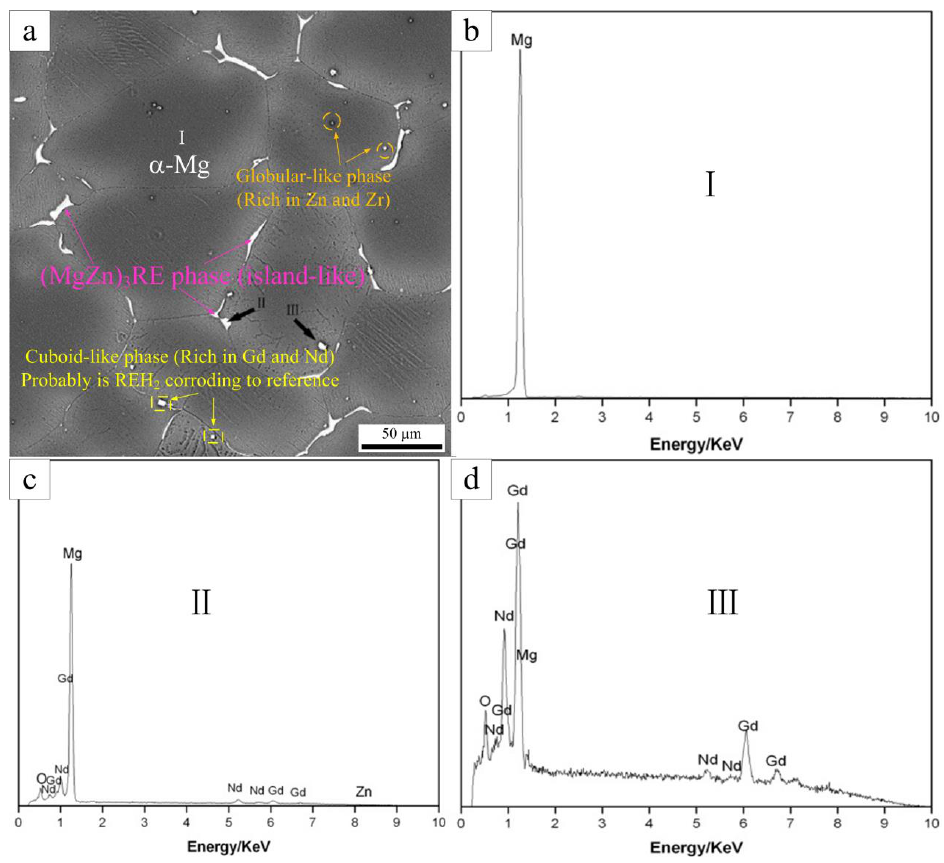
Figure 2. The SEM image of the as-cast Mg-5Gd alloy ( a ), the EDS result of point “I” ( b ), the EDS result of point “II” ( c ), and the EDS result of point “III” ( d ).